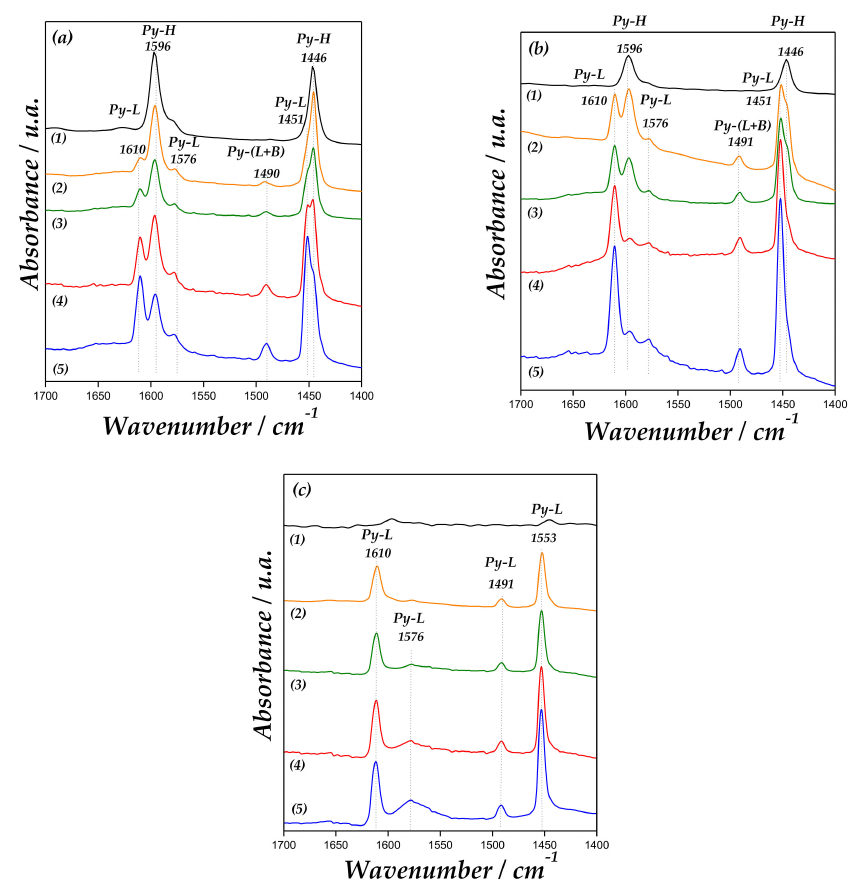
Figure 6. Fourier transform infrared (FT-IR) spectra of (1) MCM-41, (2) Zn/MCM-41(1), (3) Zn/ MCM-41(2.5), (4) Zn/MCM-41(10), and (5) Zn/MCM-41(15), containing adsorbed pyridine and subsequent desorption at 50 ◦ C (a), 100 ◦ C (b) and 200 ◦ C